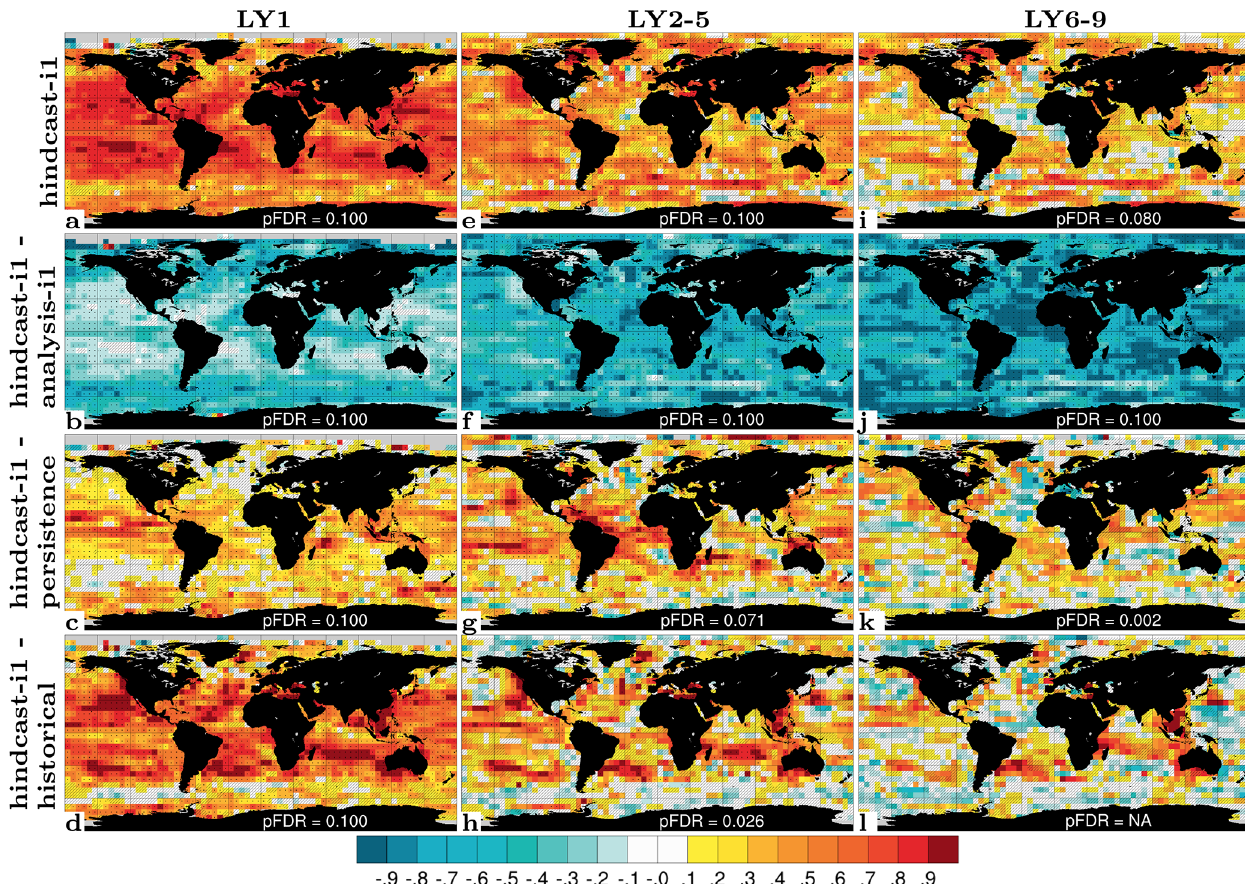
Figure 15. Potential predictability ∗ for PP. ACC of hindcast-i1 (a) , (cid:49) ACC of hindcast-i1 – analysis-i1 (b) , (cid:49) ACC of hindcast-i1 – per- sistence (c) and (cid:49) ACC of hindcast-i1 – historical (d) for LY1. The middle and right columns show the same but for LY2–5 (e–h) and LY6–9 (i–l) . Synthetic observations constructed from the ensemble mean of the first 10 members of assim-i1 with coverage for 1960–2018. Hatched areas are not locally significant; dotted areas are field